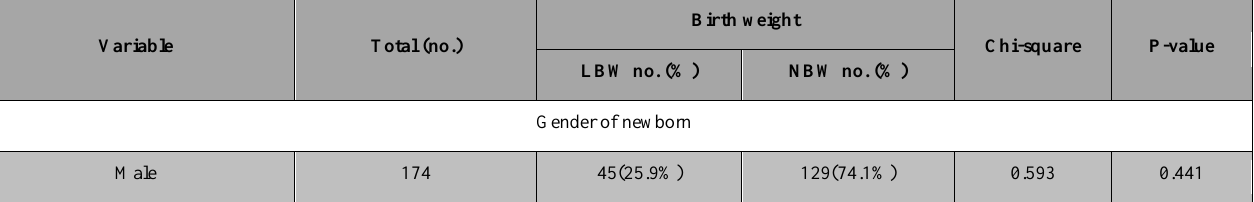
Table 1. Association of low birth weight with the gender of baby and mode of delivery